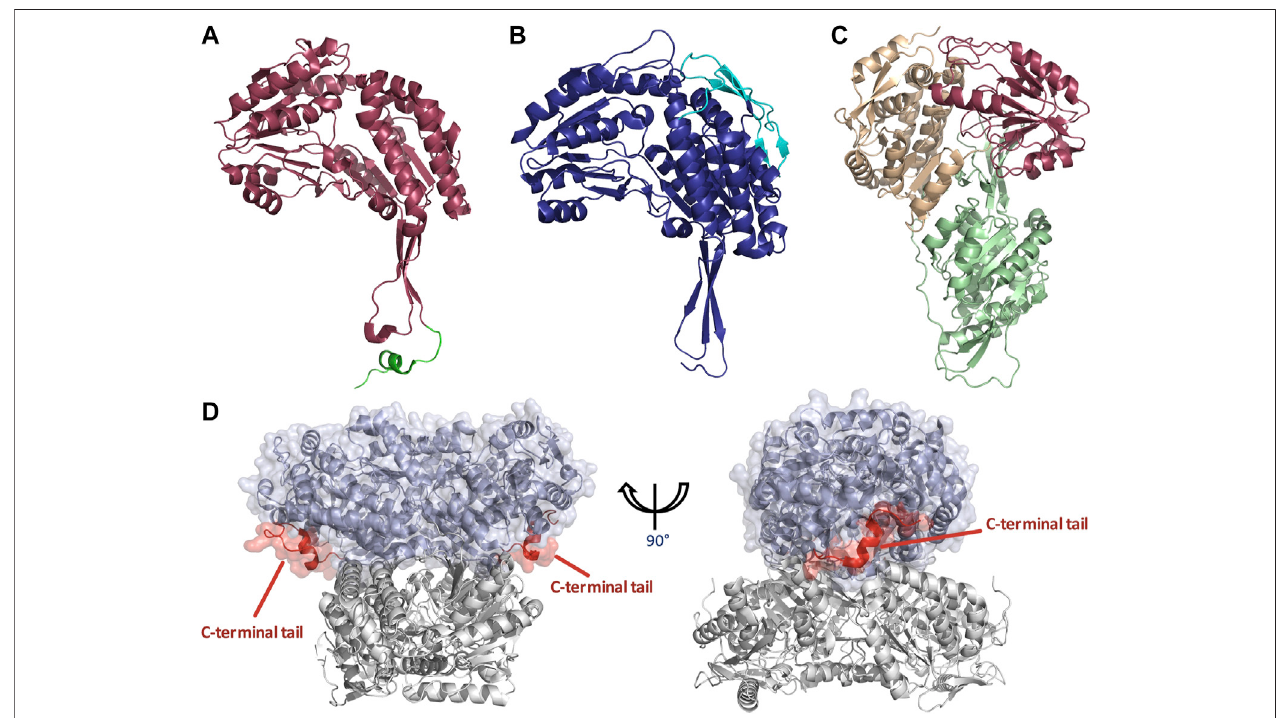
FIGURE 5 | Structural features of dimeric and tetrameric ALDHs. (A) The C-terminal tail extension of dimeric ALDHs is represented in green against the monomer of ALDH3A1(Red,PDB:3SZA).Notethedeletionofthe fi rst56aminoacidsincomparisontoimage(B)ofthetetramericALDH2(cyan). (B) The “ so-called ” N-terminalextension is represented in cyan against the monomer of ALDH2 (Blue, PDB: 1NZX).Note the absence ofthe C-terminal extendedtail. (C) LsALDH16monomer highlighting the NAD binding domain (orange), the catalytic domain(red) and an extra structural domain(green). (D) Surface representationofthe dimeric ALDH3A1 (light blue,PDB: 3SZA) superimposed on ALDH2 (Gray, PDB: 1NZX). The C-terminal tail of ALDH3A1 is depicted in red. For clarity, only the opposing dimer of ALDH2 is shown.